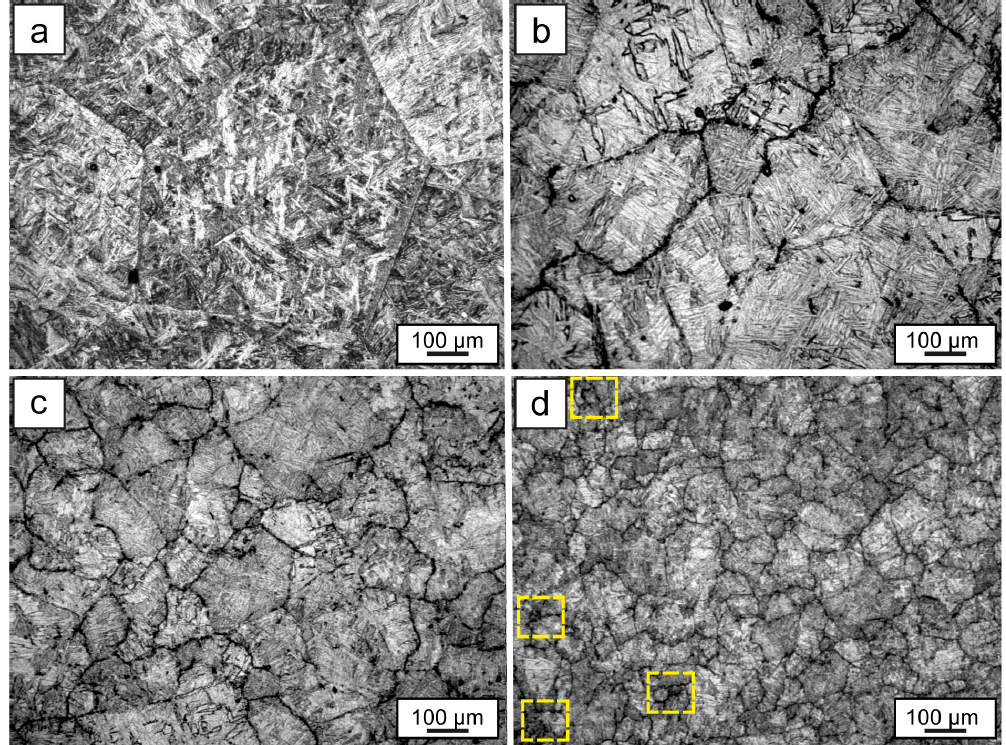
Figure 6. The metallographic microstructure of titanium matrix composites (TMCs) unmodified and modified by in situ Ti 5 Si 3 /Ti composite ribbon inoculants with different weight percentages: ( a ) TMCs unmodified; ( b ) TMCs modified with 0.2 wt. % inoculant; ( c ) TMCs modified with 0.4 wt. % inoculant; ( d ) TMCs modified with 0.6 wt. % inoculant.